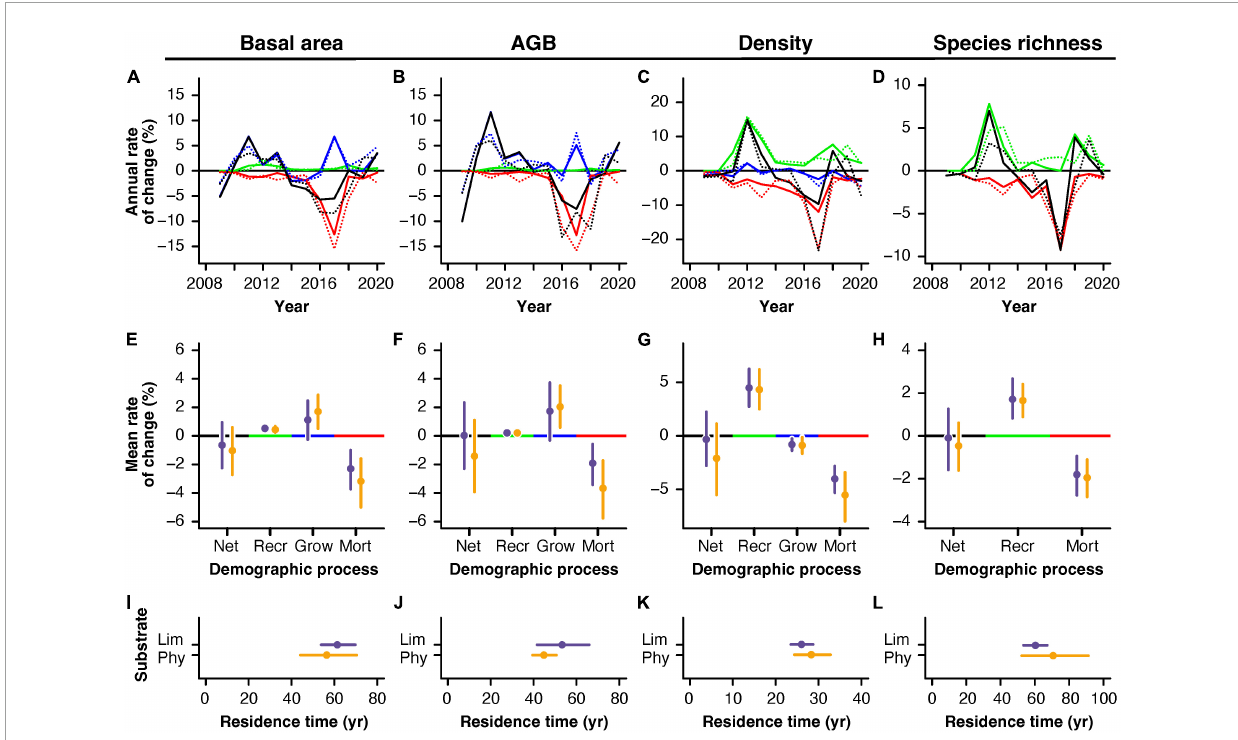
FIGURE3 Demographic rates for basal area, aboveground biomass (AGB), tree density and species richness ( 0 D ) in a tropical dry forest established over limestone and phyllite substrates. (A–D) Temporal behavior of net change (Net; black), recruitment (Recr; green), growth (Grow; blue), and mortality (Mort; red) rates on an annual resolution for limestone (continuous) and phyllite (dotted lines) permanent plots. (E–H) Mean demographic rates per substrate (dots) with 84 % confidence intervals (whiskers); overlapping whiskers around the mean estimates for limestone (purple) and phyllite (yellow) indicate non-significant mean differences with a 95 % confidence level (Goldstein and Healy, 1995). (I–L) Mean residence time for the four forest attributes on limestone and phyllite TDF plots, including mean estimates (dots) and their 84 % confidence intervals (whiskers). Forest attributes represented in each panel are indicated above the